Question: Write a caption explaining this figure to a reader.
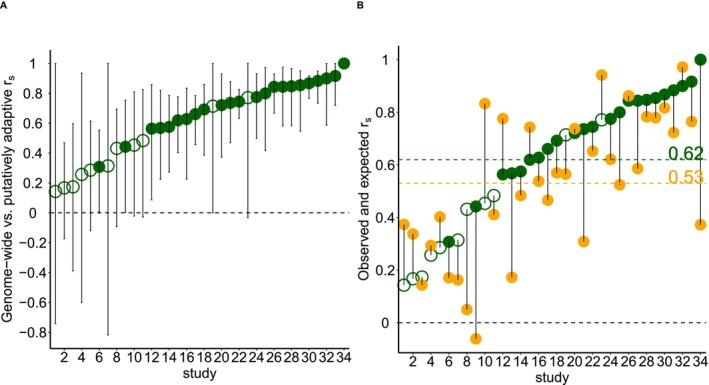
Answer: (A) The observed Spearman correlation coefficients (green points) and 90% bootstrapped confidence intervals (black lines) of population distinctiveness scores between genome‐wide and putatively adaptive SNPs ( n = 34 studies). A more positive value indicates a higher prioritization agreement between the two sets of SNPs. The hollow green points represent cases where 90% bootstrapped confidence intervals of the observed correlations overlap zero. (B) Observed (green, as in (A)) and expected (orange) Spearman correlations of population distinctiveness scores. The expected correlation for each study compares random subsets (1000 bootstrapped replicates) of genome‐wide SNPs with the full genome‐wide set. The vertical black lines for each study represent the predictive power of the putatively adaptive SNPs (see text). The average observed correlation coefficient across all 34 studies (green dashed horizontal line) is higher than the average expected correlation coefficient across all 34 studies (orange dashed horizontal line).